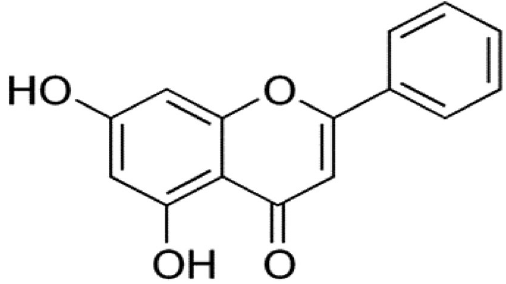
Fig. 13 Structure of chrysin (5,7-dihydroxyflavone) Fig. 14 Structure of ferulic acid